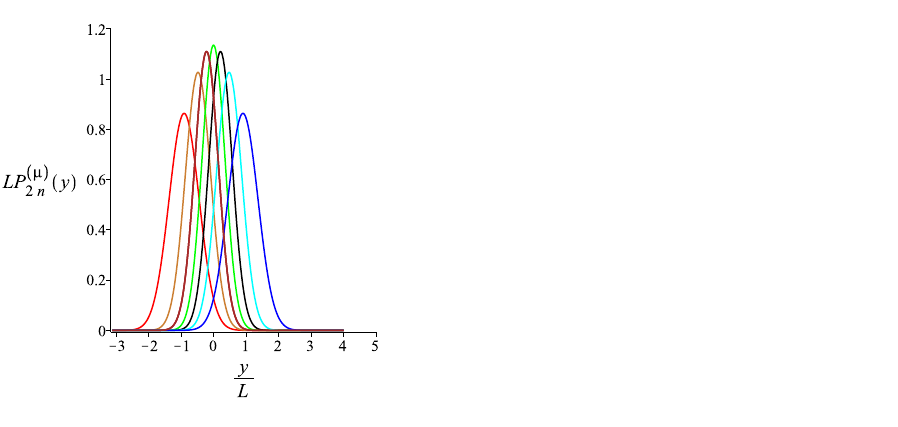
Figure 12. The probability density of the y component of the position of the free endpoint of the structure with an even number of arms. The red, gold, brown, green, black, cyan, and blue are associated with the fixed values of the orientation of the external magnetic field, φ B = − ω − π where i = 0,1,2,3,4,5,6, respectively. The other fixed parameters are: ω = π n = 1, and K B =